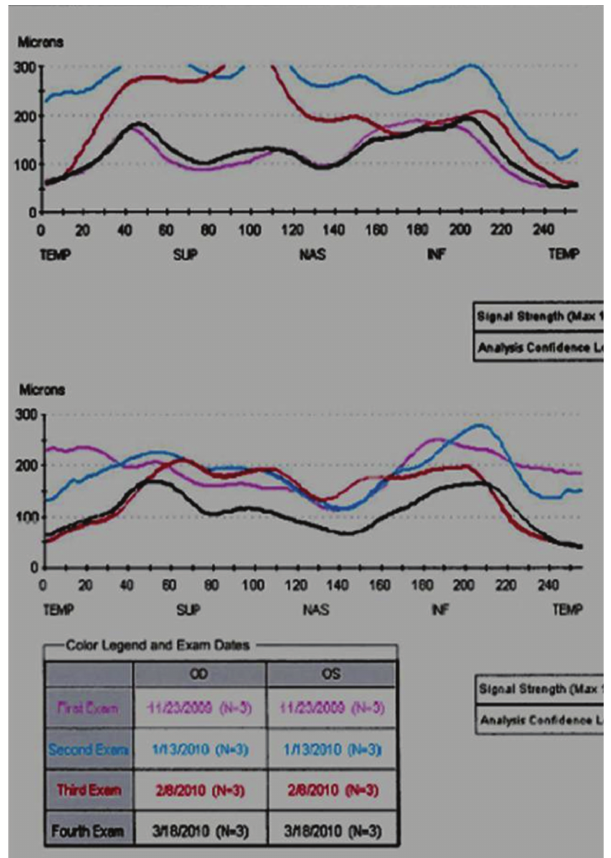
Figure 1: Composite retinal nerve fiber layer OCT. Optical coherence tomography showing extent of disc swelling during clinical course. At presentation (magenta line), disc edema is mild in the right eye, but more severe in the left eye. One and three weeks later (red and blue lines), disc edema has increased to both eyes. After treatment with antibiotics (black line), disc edema has essentially resolved.